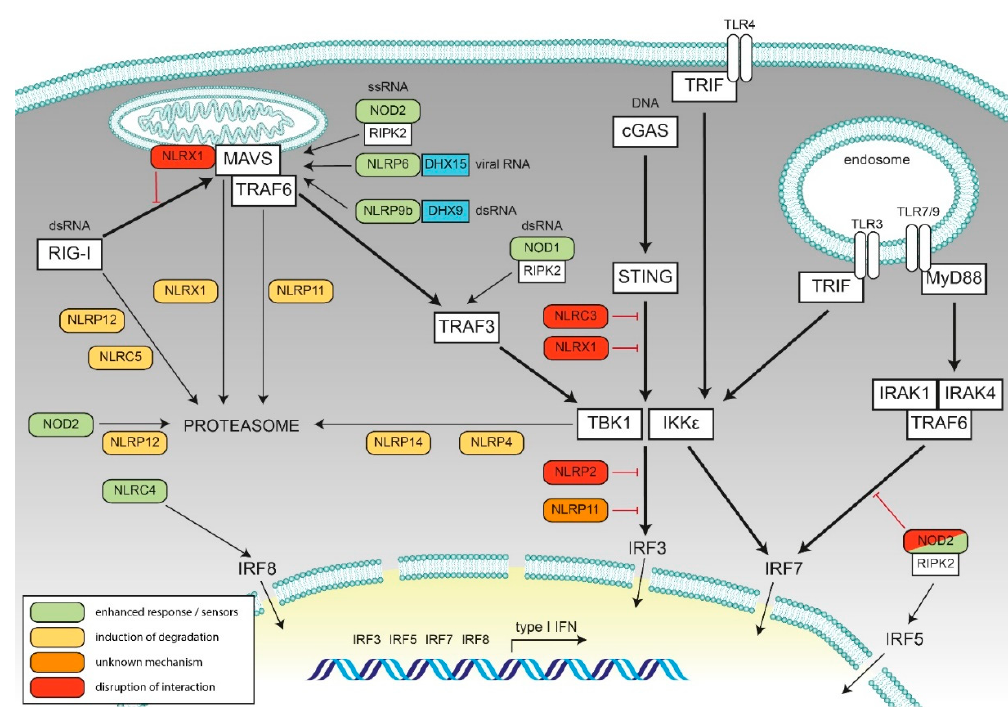
Figure 2. Schematic representation of the role of the discussed NLRs in type I interferon signaling. The key viral sensing pathway components leading to type I interferon production are shown in the white boxes, and the interferon signal transduction pathways are depicted in bold lines in a schematically depicted cell. Cooperation and interference of NLRs are shown. Green: NLRs with enhancing activity, yellow: NLRs leading to reduced interferon (IFN) response due to degradation of key components, red: Inhibition of signaling by steric hindrance, orange: Negative regulation by unknown mechanism. Cooperating factors for viral RNA sensing by NLRs are shown in blue.